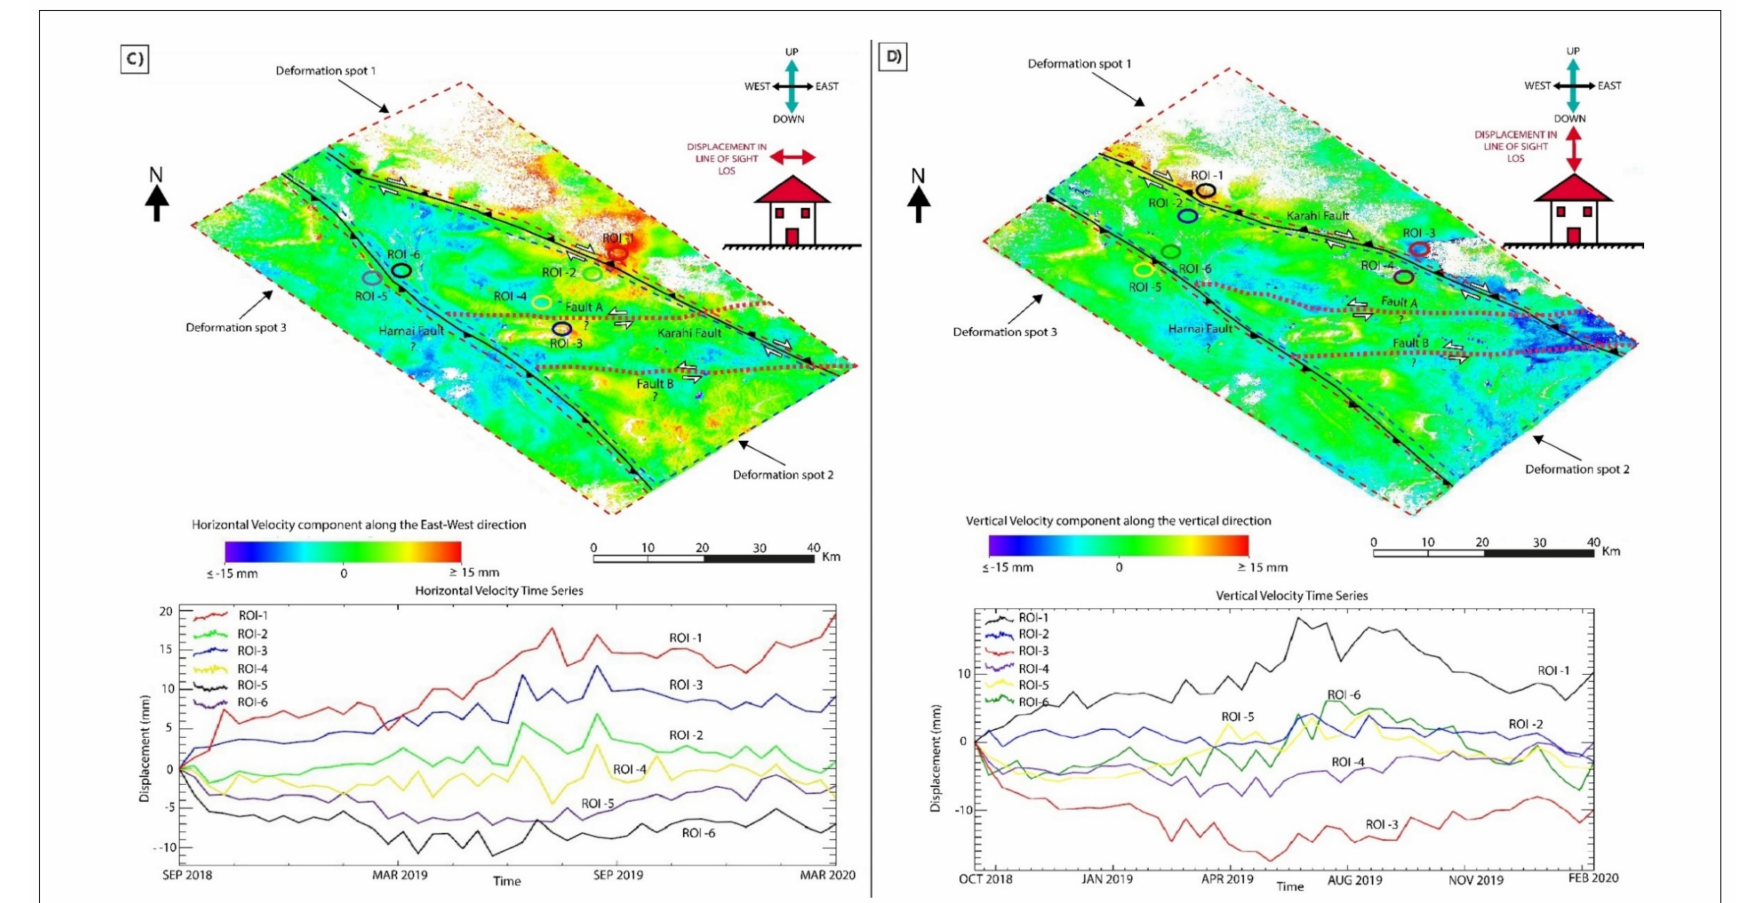
Figure 9. Image showing displacement in which red color indicates movement towards the satellite (LOS direction) or uplift, and the blue color indicates movement away from satellite or subsidence. The graph shows the time series for three regions of interest (mm). ( A ) Displacement map and time series of the descending track geometry. ( B ) Displacement map and time series of the ascending track geometry. ( C ) Map of horizontal velocity component corresponding to the east–west direction and time series. The east direction is characterized by positive values (red color); the west direction is represented by negative values. ( D ) Map of the vertical velocity component that corresponds to uplift/subsidence (up/down) direction and time series. The uplift is characterized by positive values (red color) while negative values characterize